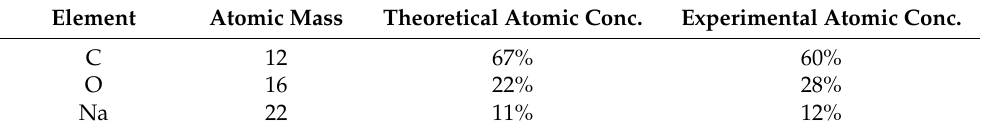
Table 1. Comparison of theoretical and experimentally determined atomic concentrations for Na-Pery. Element Atomic Mass Theoretical Atomic Conc. Experimental Atomic Conc. C 12 67% 60% O 16 22% 28% Na 22 11%